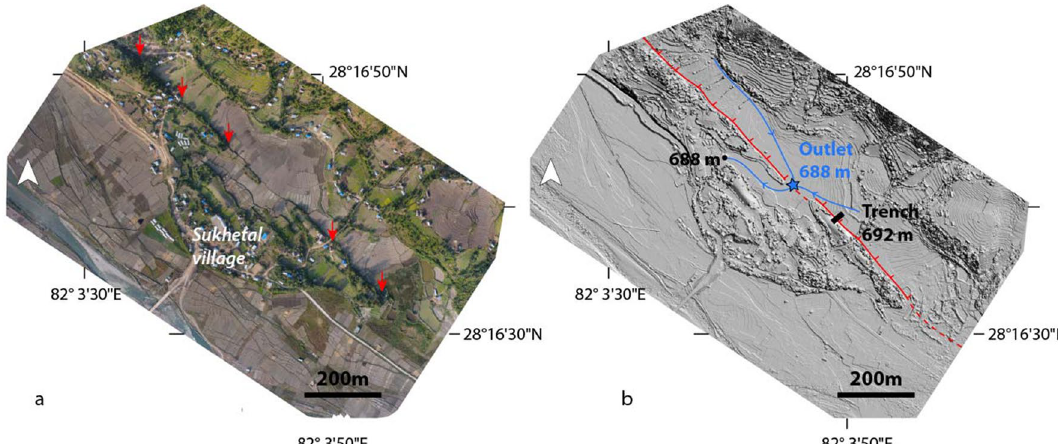
Figure 5. UAV-acquired orthomosaic ( a ) and DEM ( b ) of the Sukhetal area showing the outlet of the river catchment (blue star) at 688 m depth beneath the trench bottom. UAV: Unmanned Aerial Vehicle. Figure generated with ENVI Classic (https:// www. l3har risge ospat ial. com/ Softw are- Techn ology/ ENVI) and Adobe illustrator CS6 (http:// www. adobe. com/ fr/ produ cts/ illus trator.